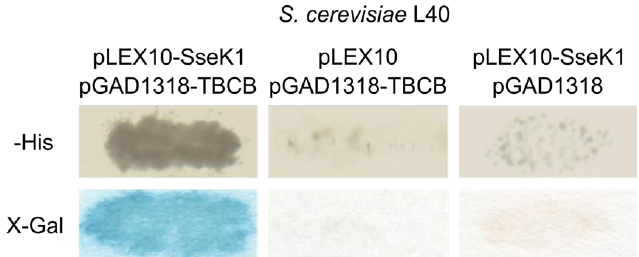
Figure 1. Human tubulin-binding cofactor B (TBCB) interacts with SseK1 in the yeast two-hybrid system. Strain L40 of S. cerevisiae was cotransformed with derivatives of plasmids pLEX10, to generate fusions with the DNA-binding domain of LexA, and pGAD1318, to generate fusions with the activation domain of Gal4, as indicated. The interaction between the two hybrid proteins is shown by the growth in the absence of histidine (-His), and the detection of blue color in the presence of X-Gal after a -galactosidase filter assay. Empty vectors were used as negative controls.